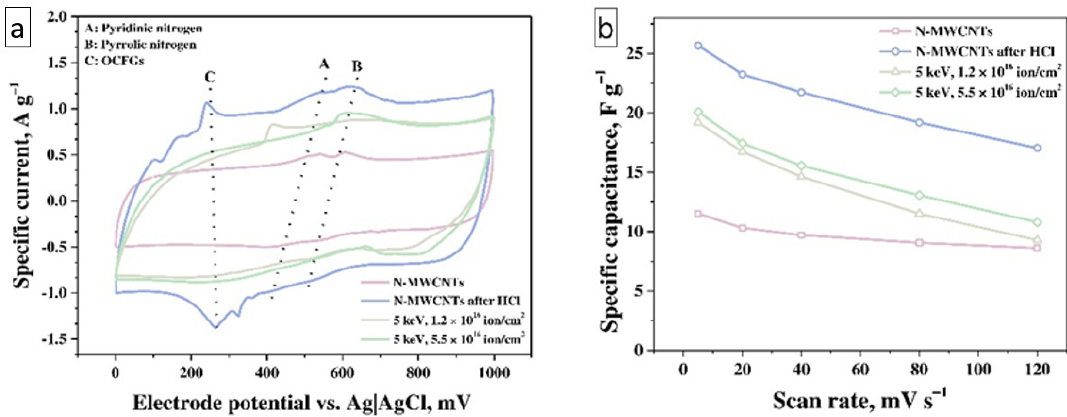
Figure 3. ( a ) The cyclic voltammograms at the scan rate of 40 mV · s − 1 and ( b ) the specific capacitance in the scan rate range of 5–120 mV · s − 1 for N-MWCNTs-based electrodes (the 1 M aqueous solution of H 2 SO 4 electrolyte) before and after